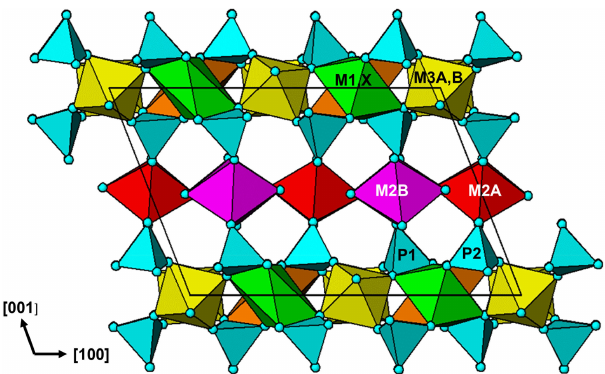
Figure 4. The [010] projection of the whiteite-type structure using ATOMS (Dowty, 2006).